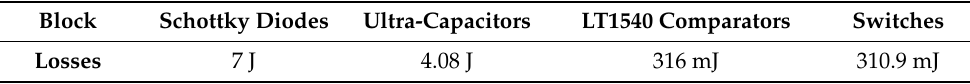
Table 2. Energy consumption of each respective block in the new variable storage structure computed by LTspice simulation for a total supplied energy of 216 J and energy provided to the load of 204.4 J. Block Schottky Diodes Ultra-Capacitors LT1540 Comparators Switches Losses 7 J 4.08 J 316 mJ 310.9 mJ